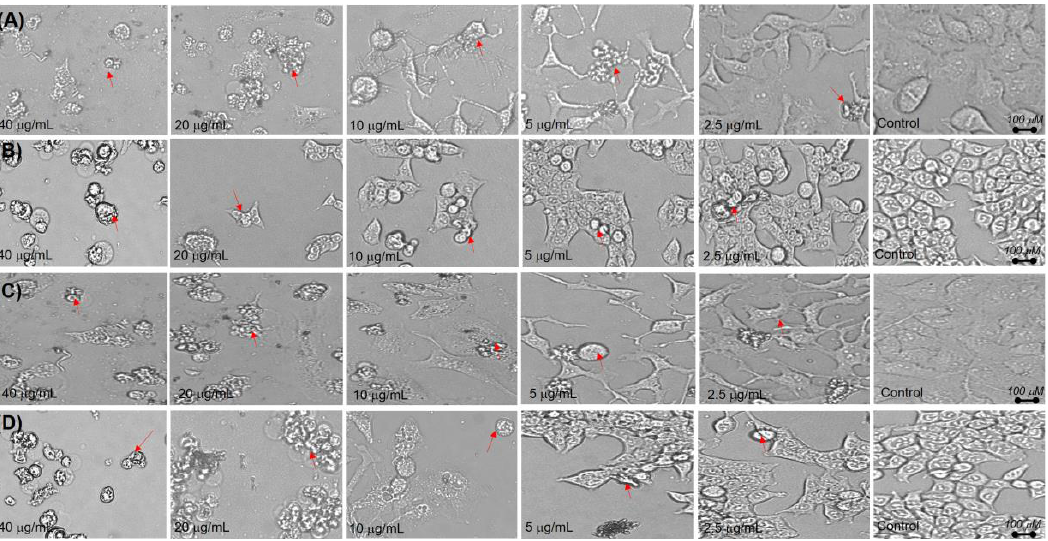
Figure 5. Morphological alterations of cells after 48 h caused by ( A ) β-S on HepG2 cells, ( B ) β-S on Huh7 cells, ( C ) β-SG on HepG2 cells, and ( D ) β-SG on Huh7 cells